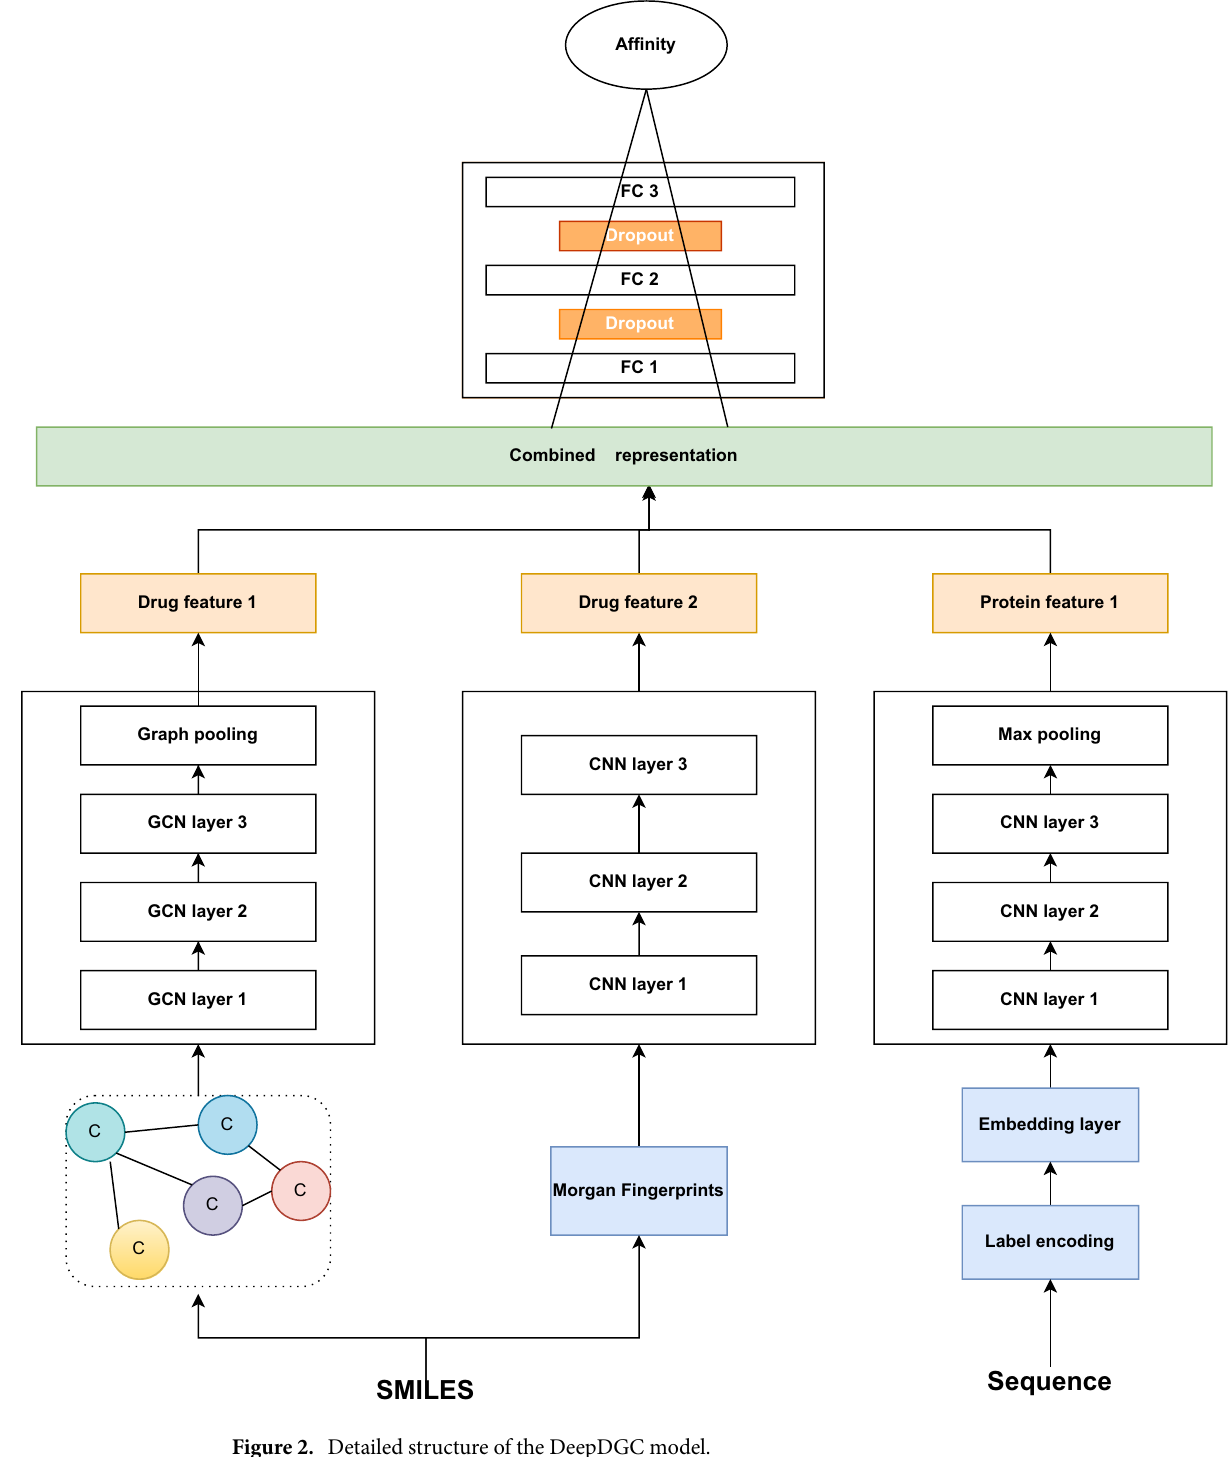
Figure 2. Detailed structure of the DeepDGC